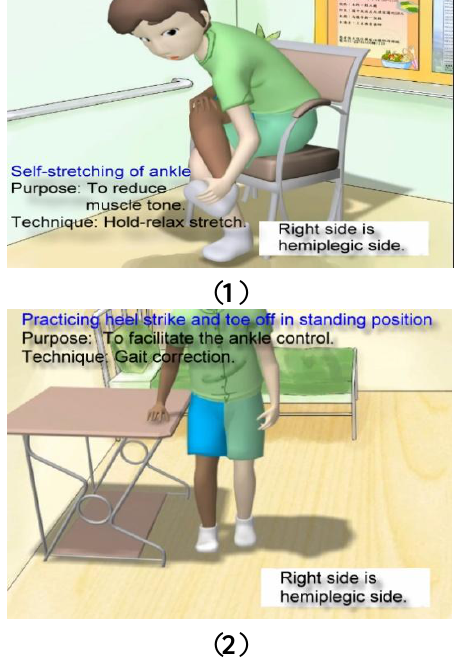
Figure B1. The 3D animation exercise videos for hemiplegic patients*. (Dark color: Hemiplegic side); ( 1 ) Self-stretching of ankle; ( 2 ) Practicing heel strike and toe off in standing position; ( 3 ) Stepping in different